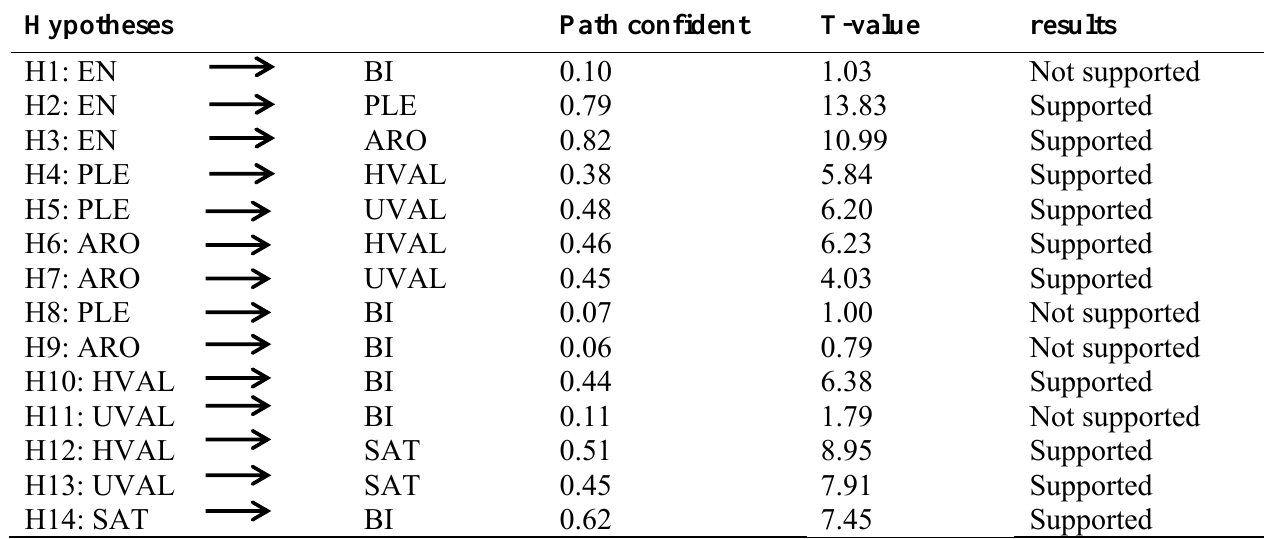
Path estimates and hypotheses results for proposed model Hypotheses Path confident